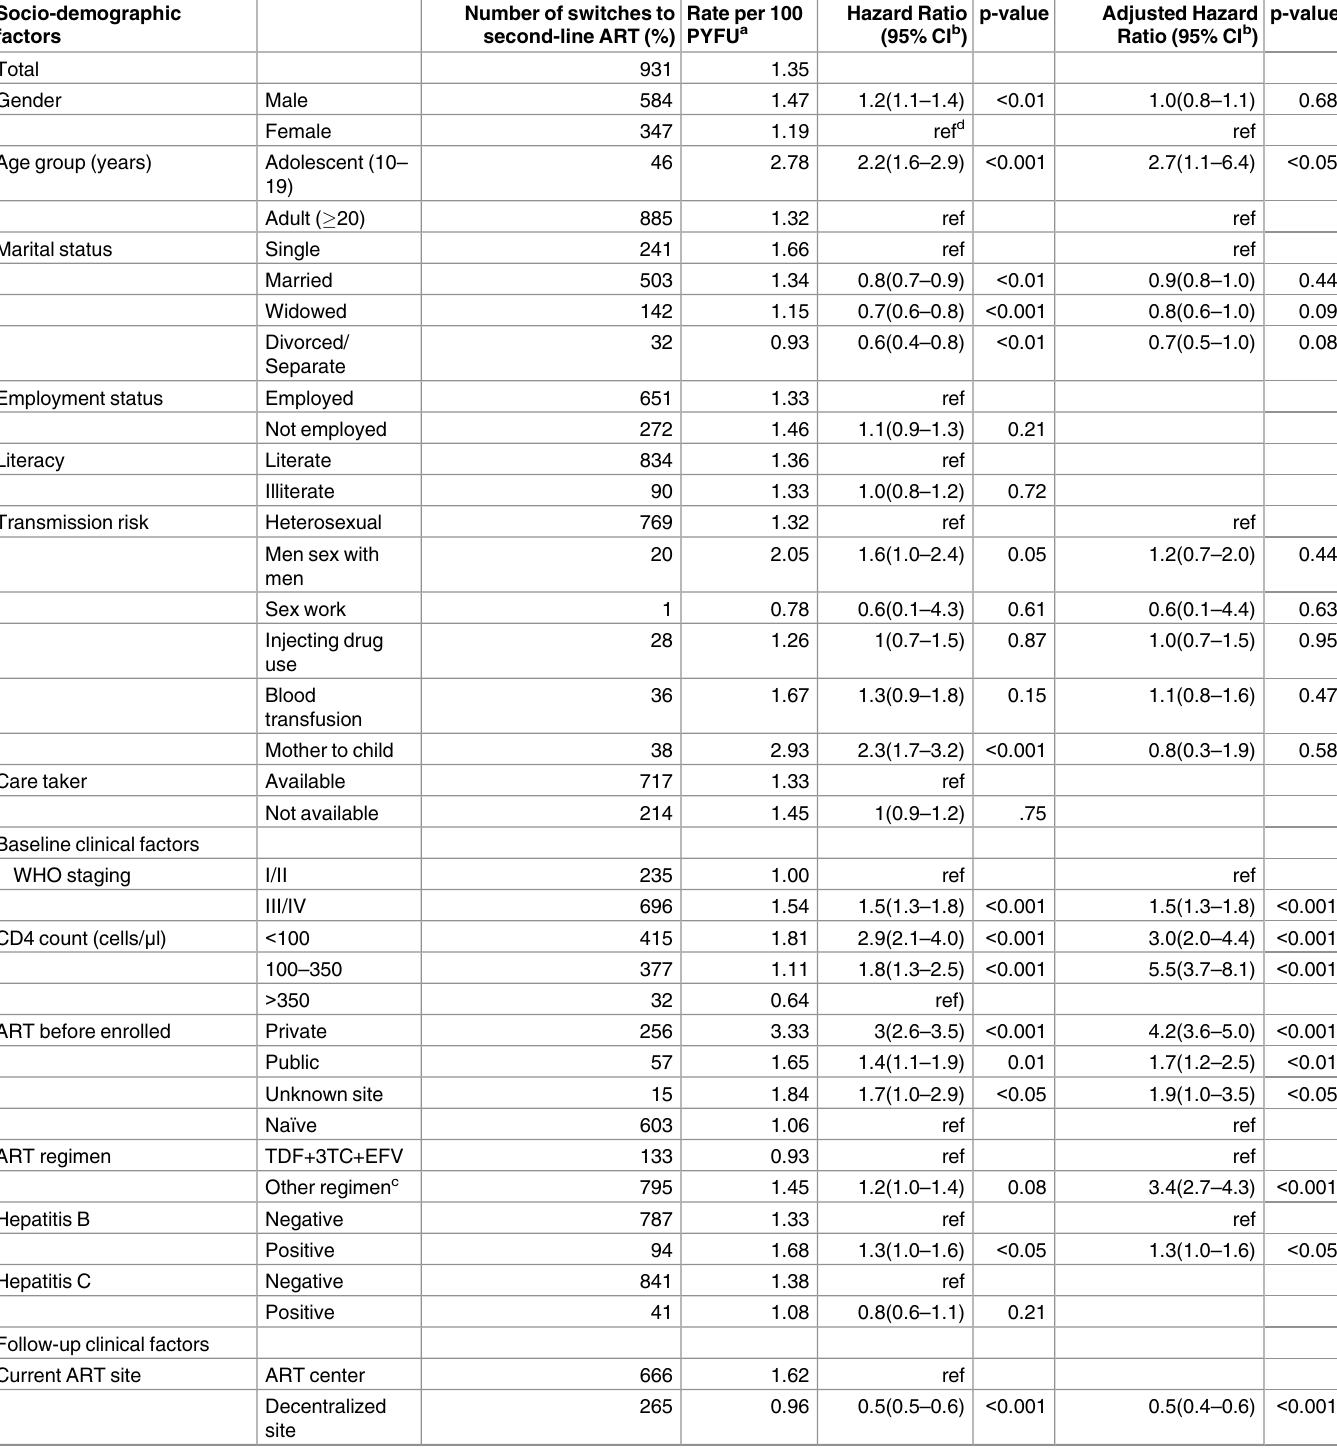
Table 3. Rates and predictors of switching to second-line ART in patients on first-line ART, Integrated HIV and Care Program, Myanmar, between 2005 and 2015. Socio-demographic